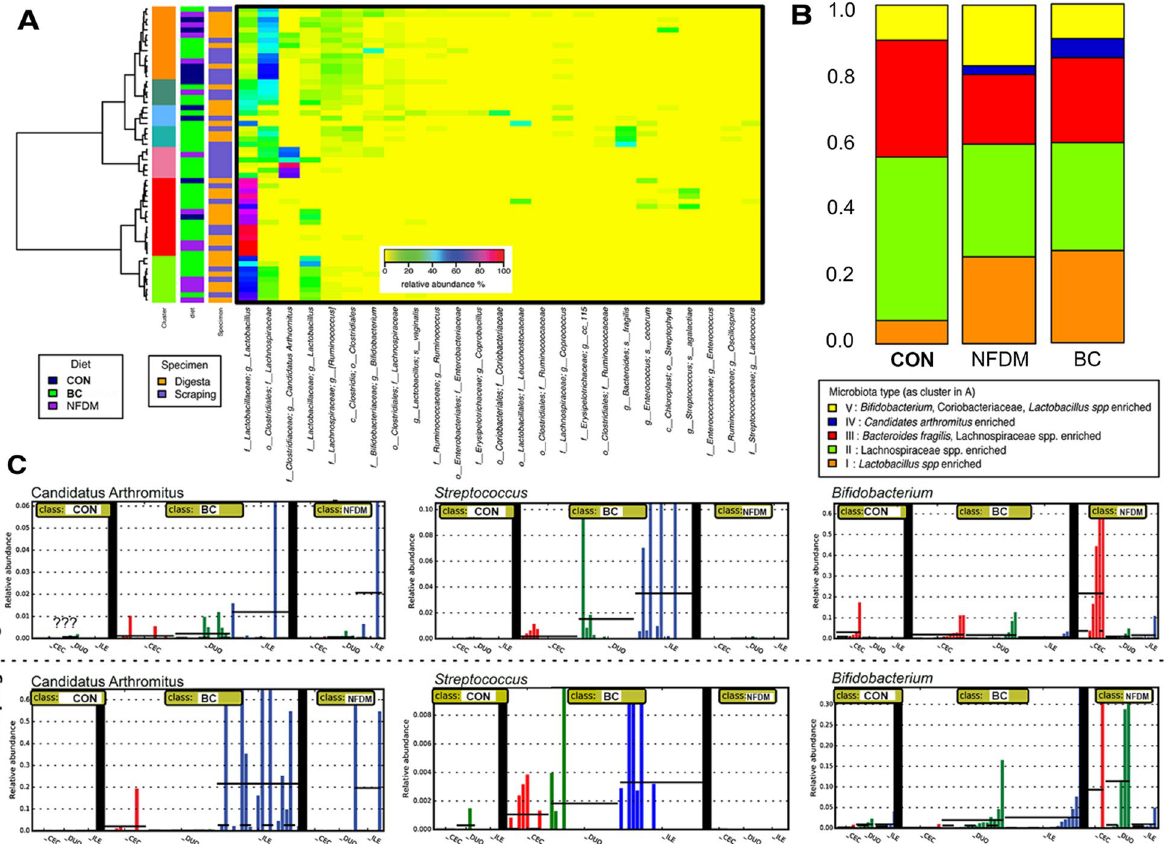
Fig. 5 Chicken intestinal microbiota analyses. A Heatmap of the 50 most abundant phylotypes of 156 samples collected. Five types of intestinal microbiota were revealed based on clustering patterns. Ward linkage clustering is used to cluster samples based on their Jensen-Shannon distance calculated in vegan package in R [116]. Identified microbiota types are labeled as I–V. B Distribution of different community type by cluster as shown in A in diet treatment groups of Control, colostrum and NFDM. Type I is significantly lowered in control than in other two groups while type IV is significantly higher in BC and NFDM. Type II is borderline significantly higher in BC and NFDM than control, based on statistical modeling using Bayesian Poisson model. C Phylotype biomarkers for digesta and scrapings generated using program LEfSe [105]. Vertical bars represent the relative abundance of Bacteriodes in each sample. Dotted line represents mean, solid line represents median relative abundance. The alpha value for the non-parametric factorial Kruskal–Wallis (KW) sum-rank test was 0.05 and the threshold for the logarithmic LDA model (43) score for discriminative features was set at